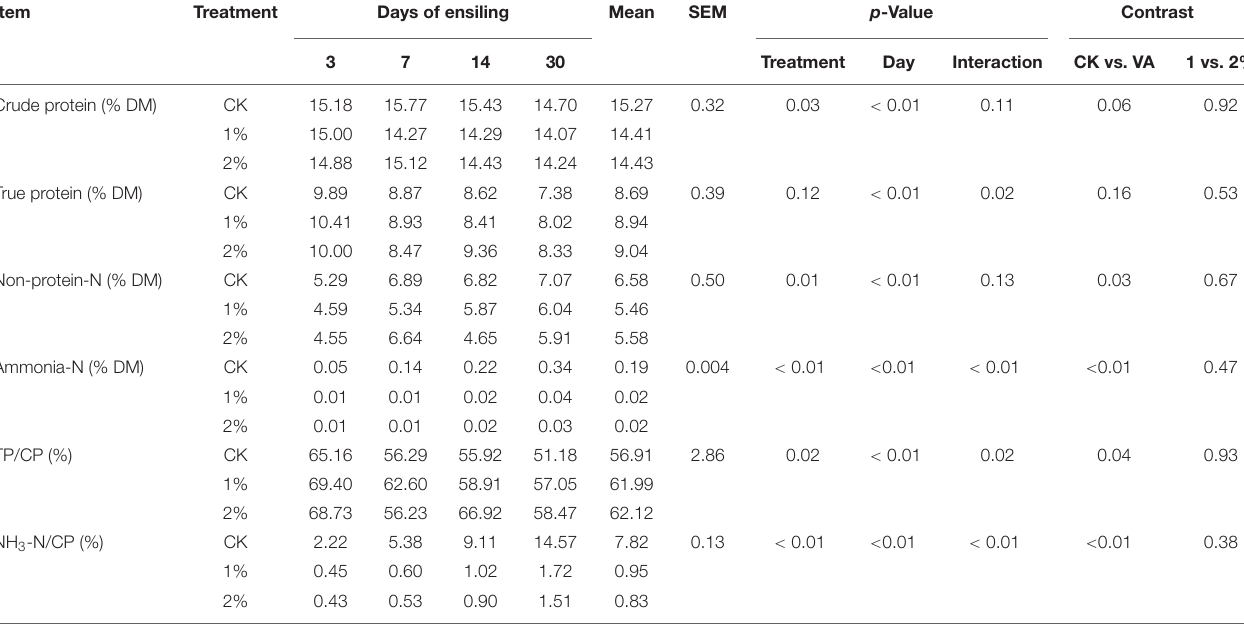
TABLE 2 | Effect of vanillic acid on dynamic nitrogen distribution of stylo silage. Item Treatment Days of ensiling Mean SEM p -Value Contrast